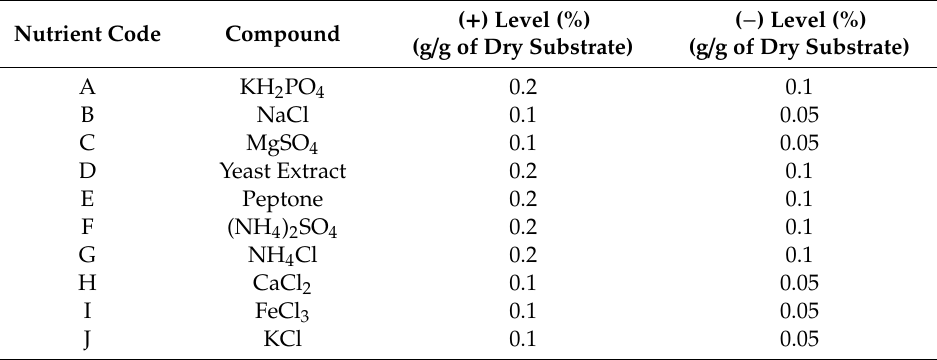
Table 2. Nutrient supplements for the screening of nutrients using Plackett–Burman method. Nutrient Code